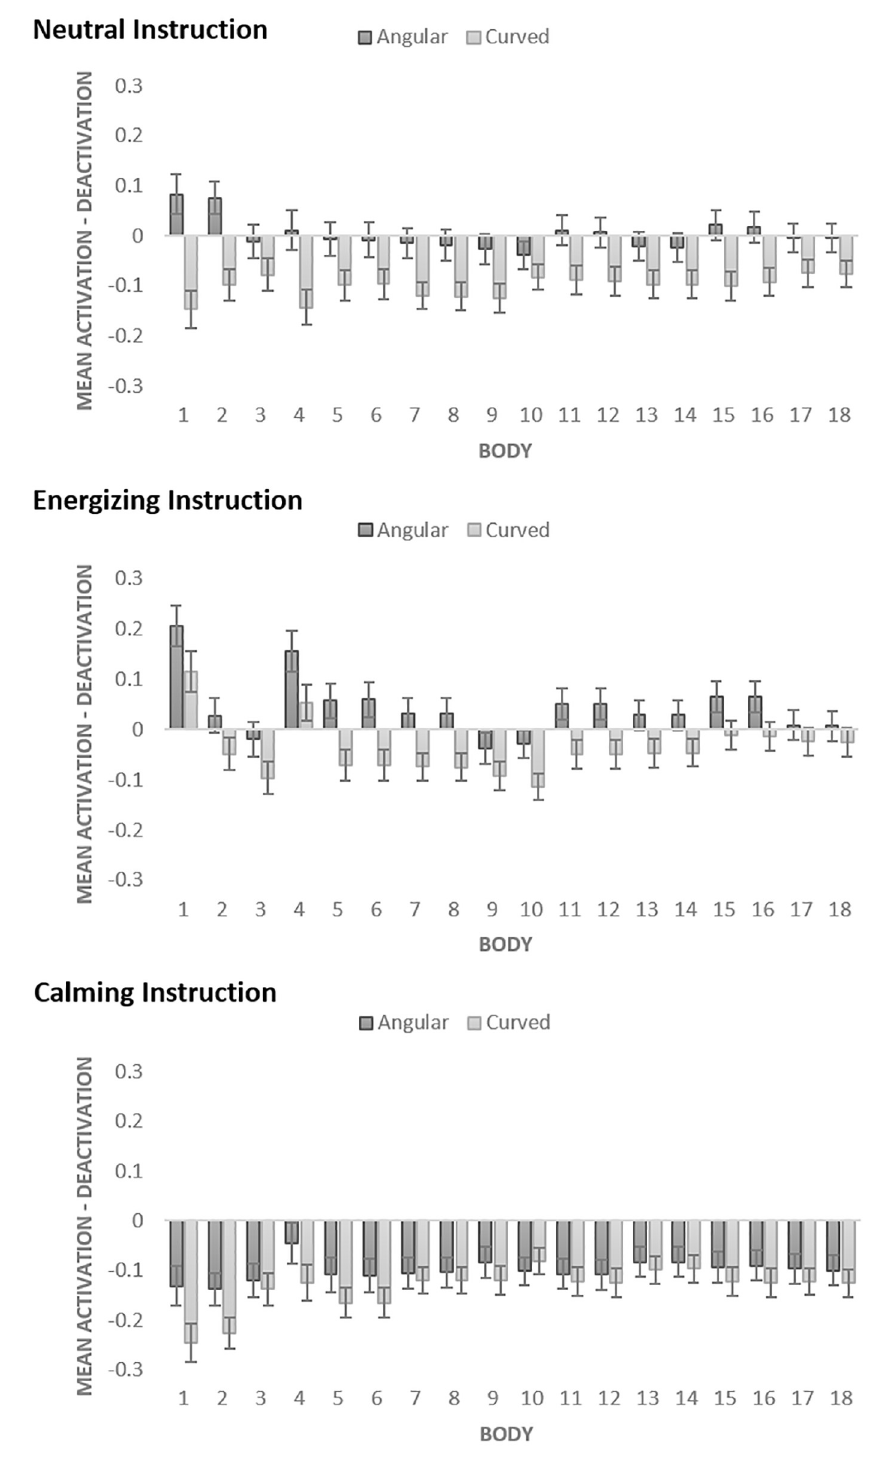
Fig 10. Activation-Deactivation in bodily sensations evoked by angular vs. curved pills in Study 3b. The bars represent SE.